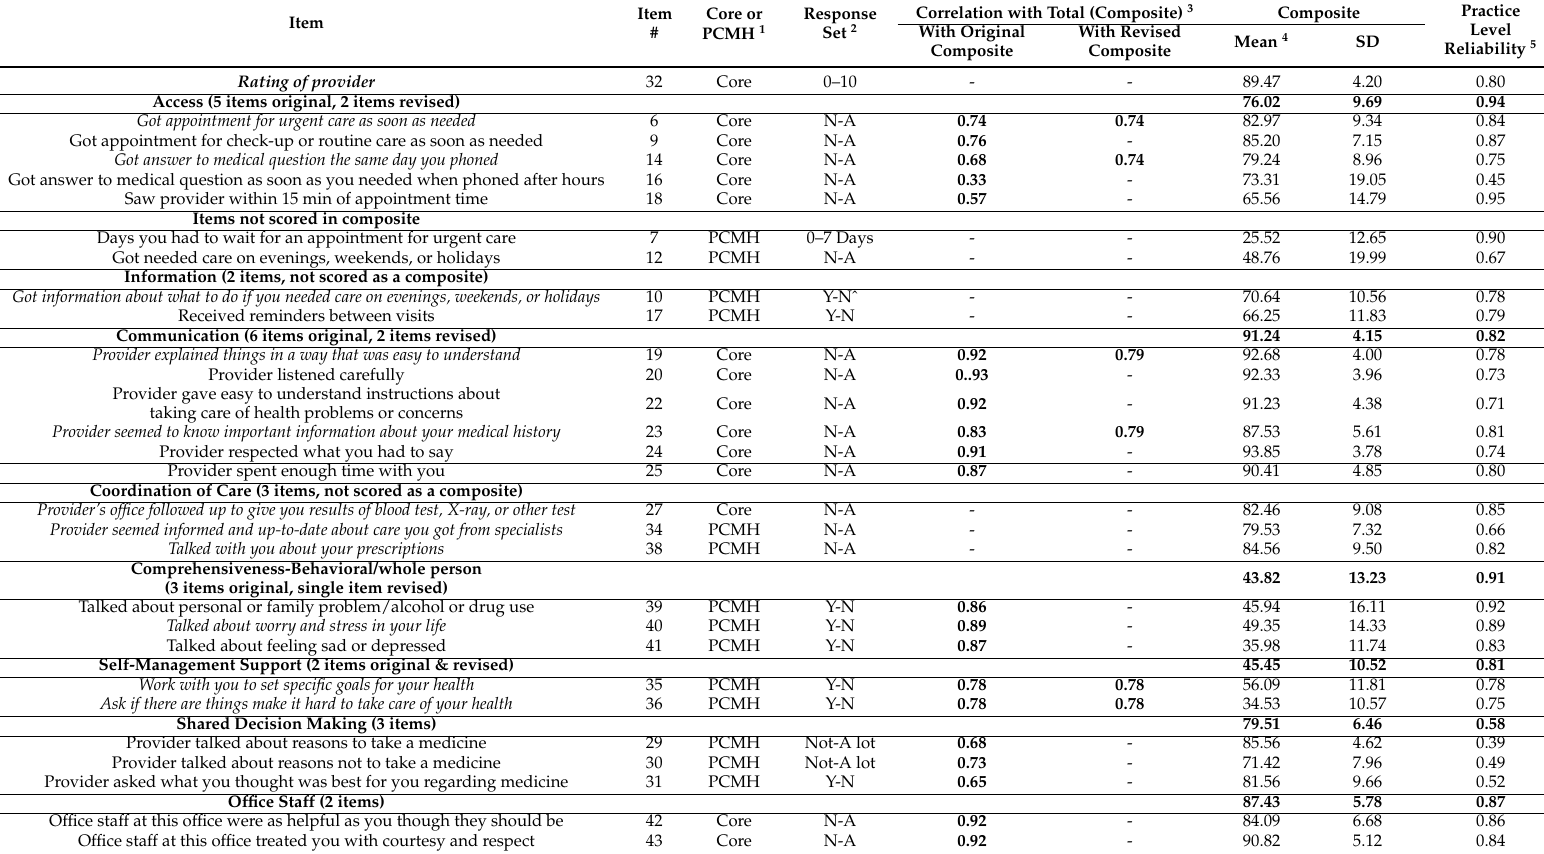
Table 2. 2013 results for the adult CAHPS PCMH Survey ( n = 268 practices). Items in italics recommended for revised